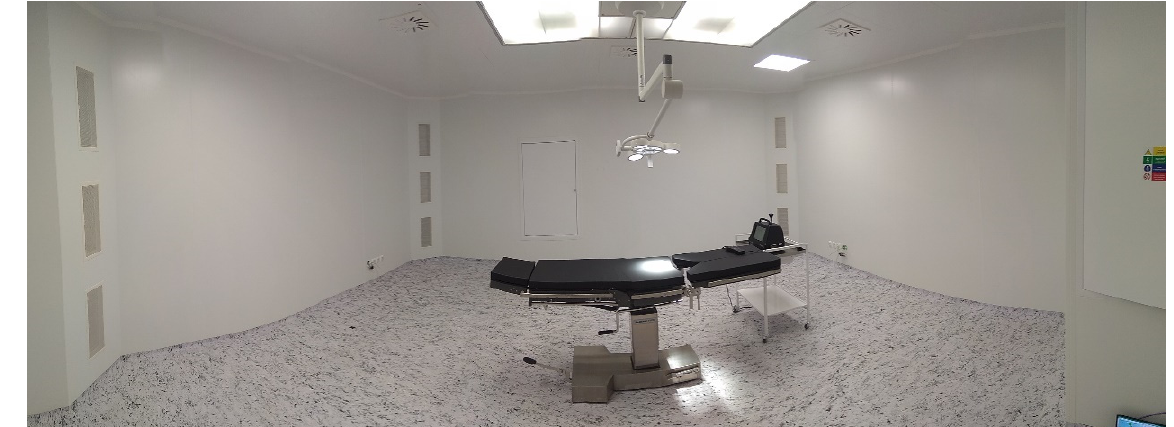
Figure 2. Experimental clean room laboratory.